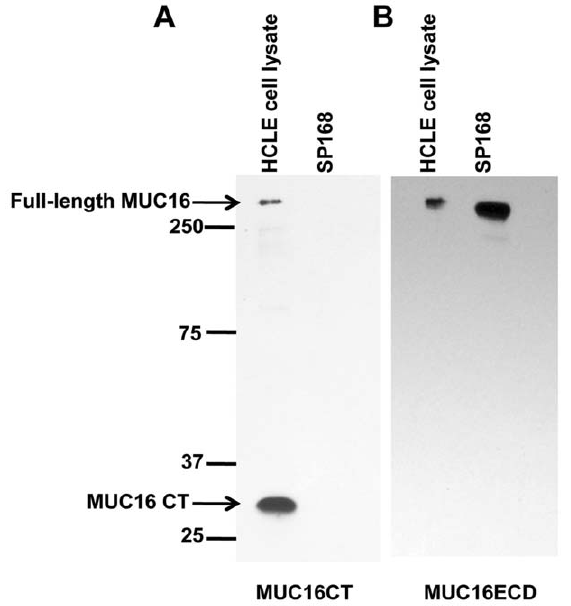
Figure 2. MUC16 released from epithelial surfaces by SP168 does not bind to a MUC16 cytoplasmic tail antibody indicating ectodomain release. HCLE cells were cultured with growth culture filtrate obtained from strain SP168 for 1 hour (SP168), and the resultant media was diluted 1:3 with DMEM/F12, and subjected to a 10 kDa cutoff concentrator. HCLE cell lysate with intact full-length MUC16 (75 m g) was used as a positive control. Western blot of the resulting concentrate and cell lysate using: A ) MUC16CT antibody that recognizes full-length MUC16 at . 250 kDa and the cytoplasmic tail between 25–37 kDa, or B ) MUC16 extracellular domain (ECD) antibody (M11). The MUC16CT antibody binds to the positive control cell lysate only (arrow), but not to the cell culture supernatants after exposure to SP168 (A). Conversely, M11 antibody binds to a band of appropriate molecular weight in culture supernatants as well as the cell lysate (B). These data indicate that the sheddase releases the MUC16 ectodomain into the cell culture media. Molecular weight standards are on the left in kDa.